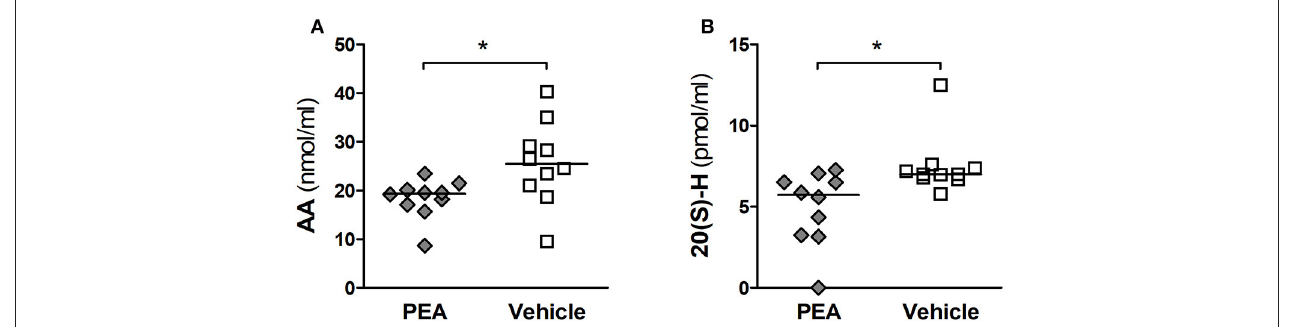
FIGURE 6 | PEA reduces AA serum levels and its subsequent oxidation into 20-HETE in aged mice with meningitis. (A) Concentrations of arachidonic acid (AA, in nmol/ml), and (B) levels of 20-hydroxyeicosatetraenoic acid (HETE, in pmol/ml) were lower in the serum of aged infected animals pre-treated with PEA than in infected mice pre-treated with vehicle ( n = 10/group). Serum levels of PEA and PGE 2 were not significantly altered. * P < 0.05 between PEA and vehicle groups, using the Mann–Whitney U -test followed by Holm–Bonferroni correction for multiple testing.